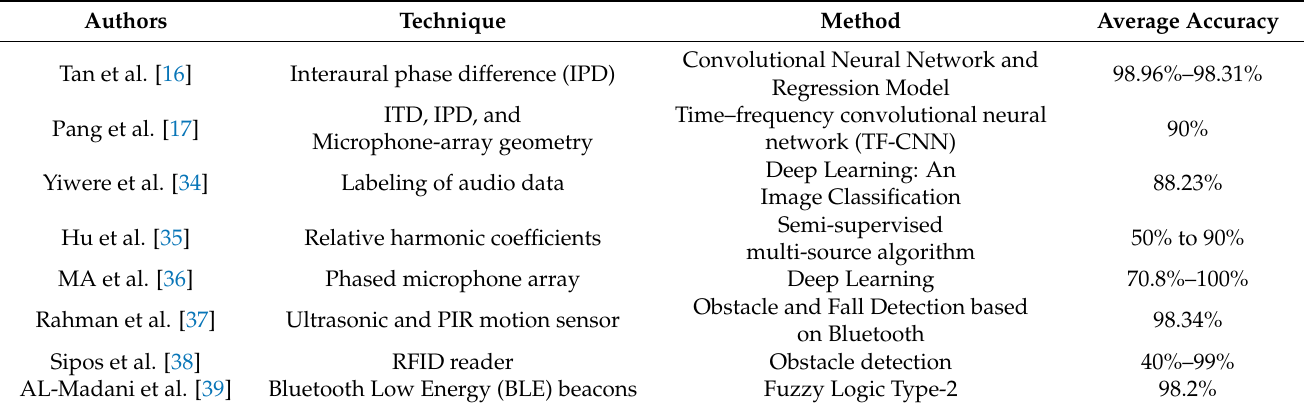
Table 7. Summarizing the technique, method, and accuracy for different